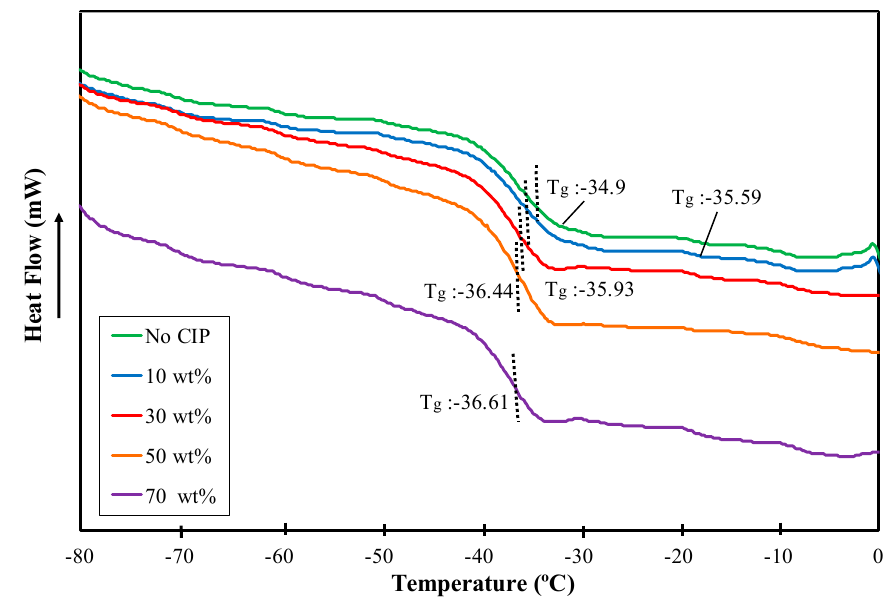
Figure 4. Differential Scanning Calorimetry curves for ENR-based MREs for different CIPs loading.